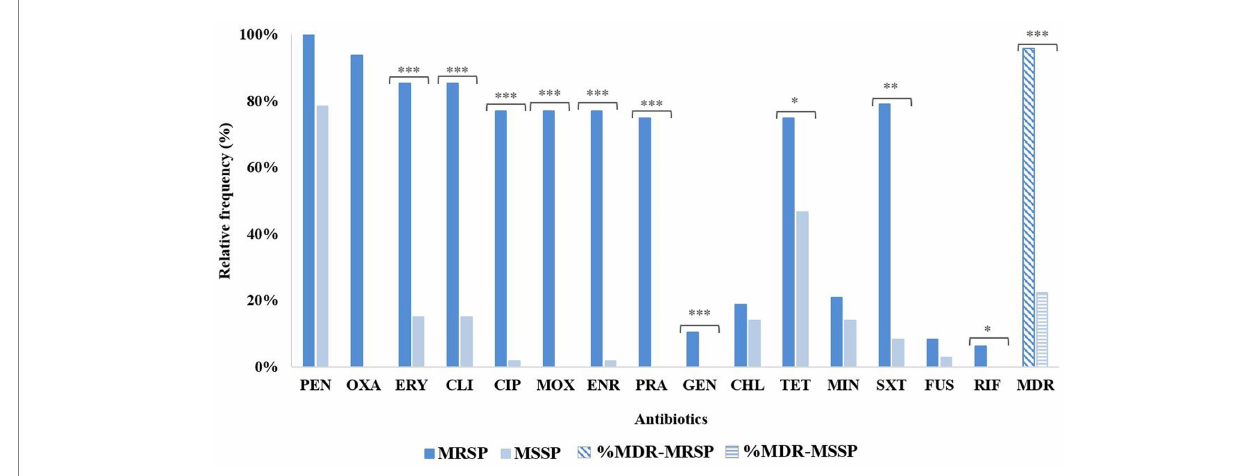
FIGURE 2 Distribution of antimicrobial resistance profiles for MRSP ( n = 48) and MSSP ( n = 107), including MDR frequency. PEN, penicillin; OXA, oxacillin; ERY, erythromycin; CLI, clindamycin; CIP, ciprofloxacin; MOX, moxifloxacin; ENR, enrofloxacin; PRA, pradofloxacin; GEN, gentamycin; CHL, chloramphenicol; TET, tetracycline; MIN, minocycline; SXT, trimethoprim-sulfamethoxazole; FUS, fusidic acid; RIF, rifampicin; MDR, multidrug resistance. Statistical differences are represented as follows: *** p < 0.00001; ** p < 0.0001; * p <